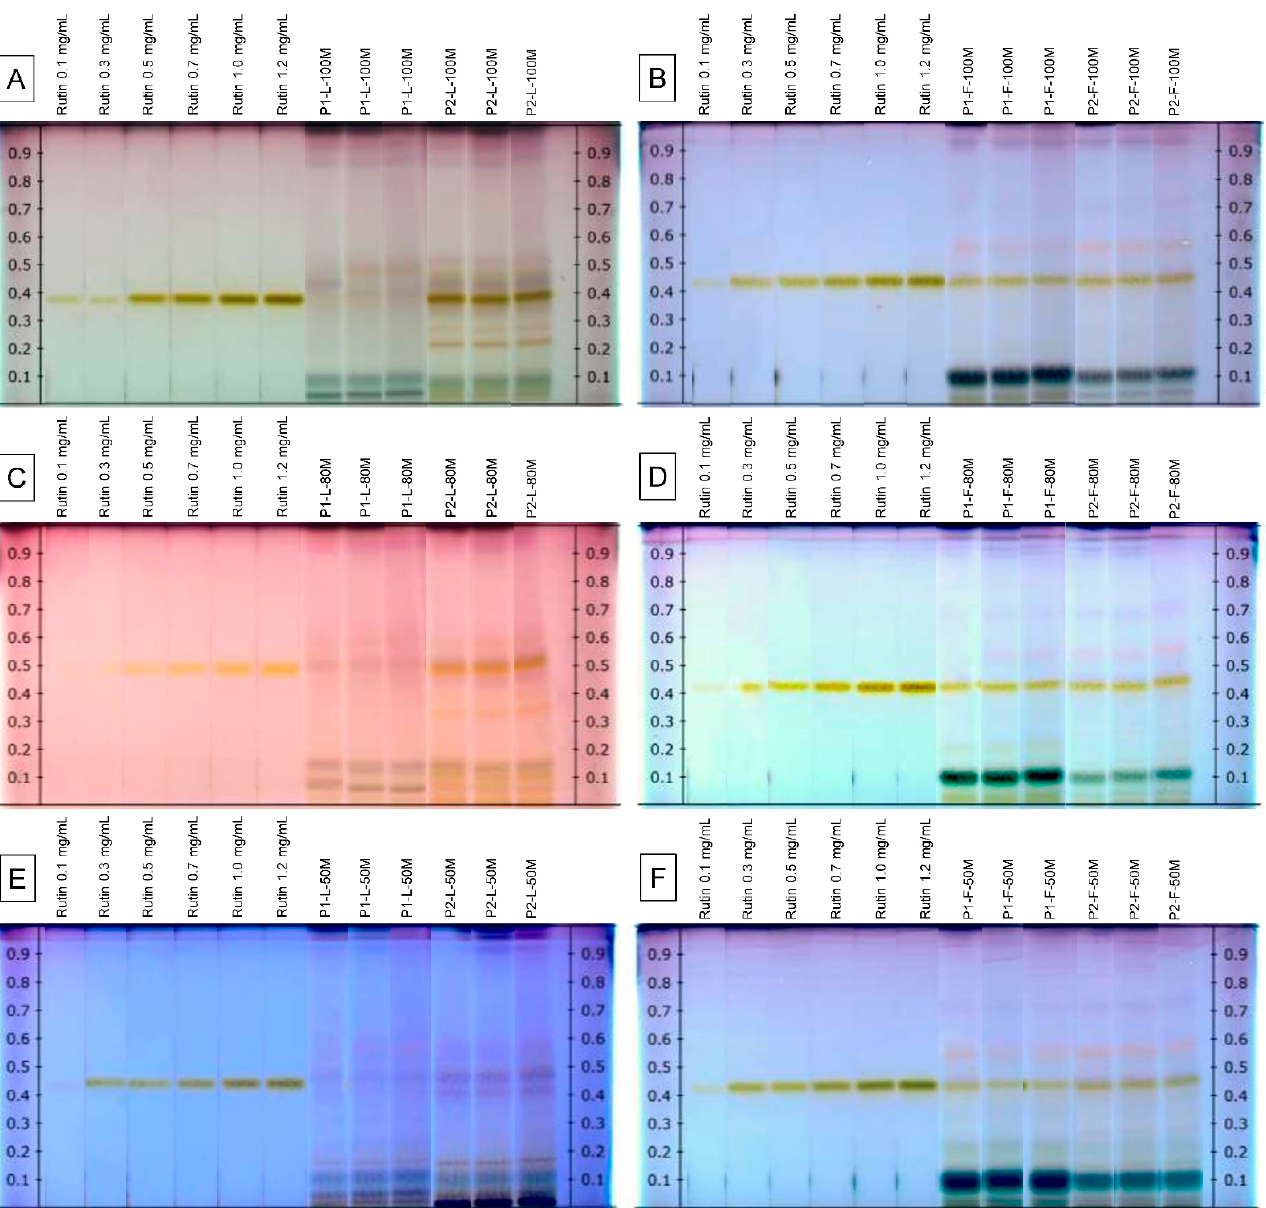
Figure 2. HPTLC chromatogram of methanolic extracts from Verbesina sphaerocephala under visible light in the transmittance mode after derivatization with p -anisaldehyde. ( A ) Leaf tissue from Populations 1 and 2 extracted with 100% methanol. ( B ) Flower tissue from Populations 1 and 2 extracted with 100% methanol. ( C ) Leaf tissue from Populations 1 and 2 extracted with 80% methanol. ( D ) Flower tissue from Populations 1 and 2 extracted with 80% methanol. ( E ) Leaf tissue from Populations 1 and 2 extracted with 50% methanol. ( F ) Flower tissue from Populations 1 and 2 extracted with 50% methanol.